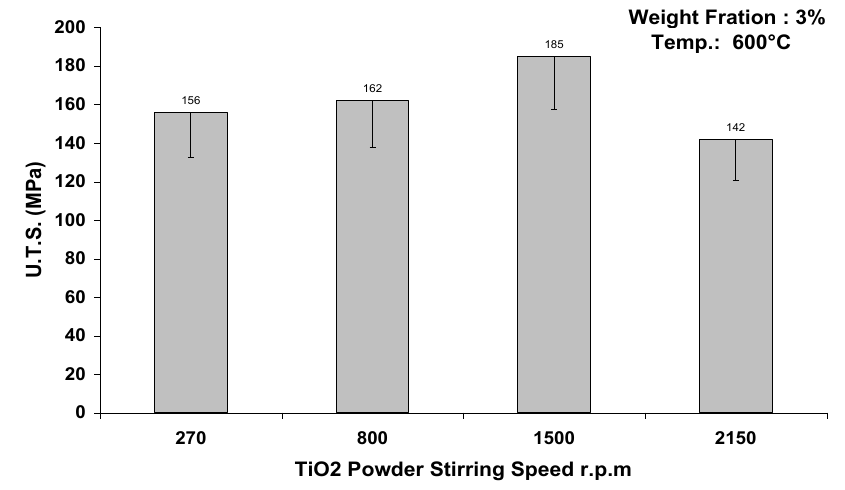
Figure 6. The effect of stirring speed on the UTS of 3 weight% TiO 2 nanoreinforced alloy at 600